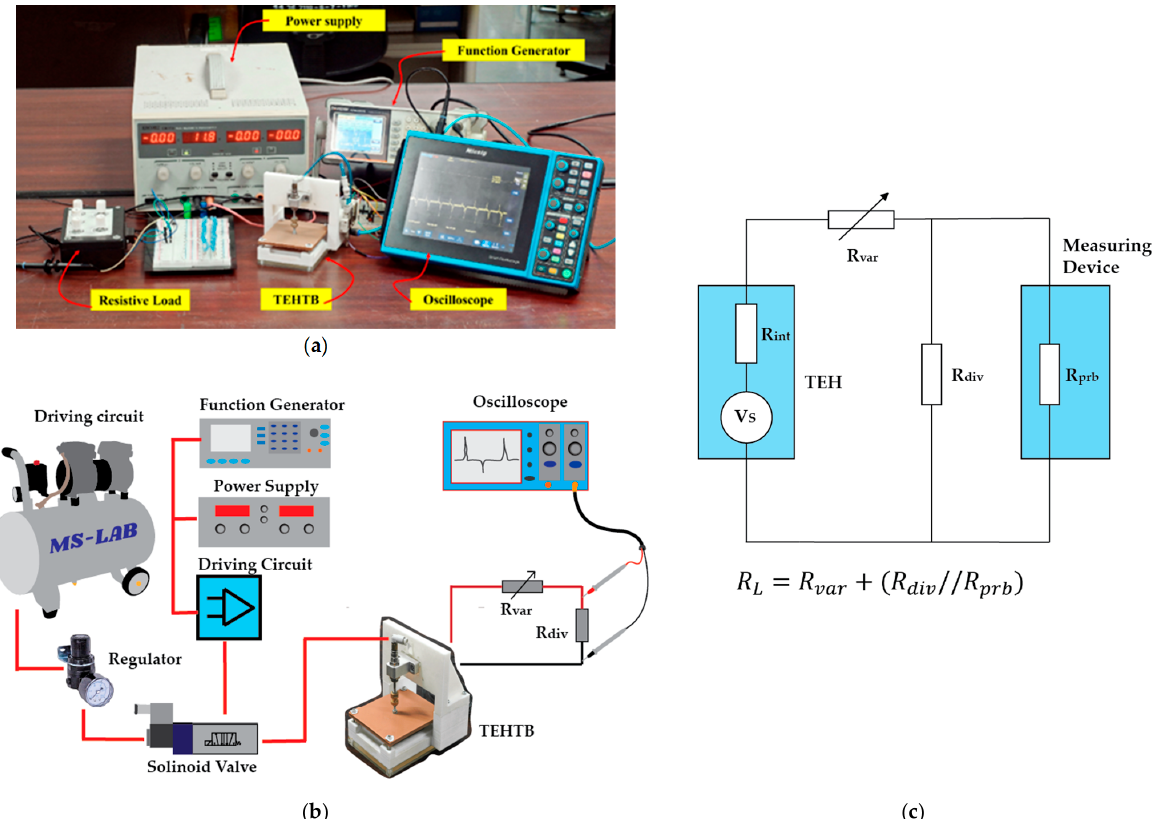
Figure 3. ( a ) The experiment setup for the TEHTB; ( b ) the schematic of the experimental setup; and ( c ) the schematic diagram of the measurement technique.